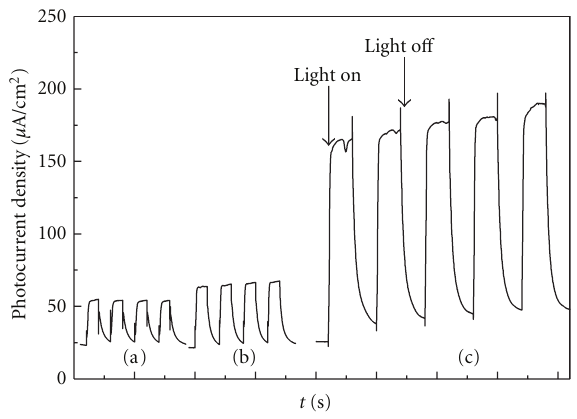
Figure 1: Photocurrent density over (a) pure BiVO 4 , (b) mixture of BiVO 4 and MWCNTs, and (c) BiVO 4 @MWCNTs composite films under visible light ( λ ≥ 420